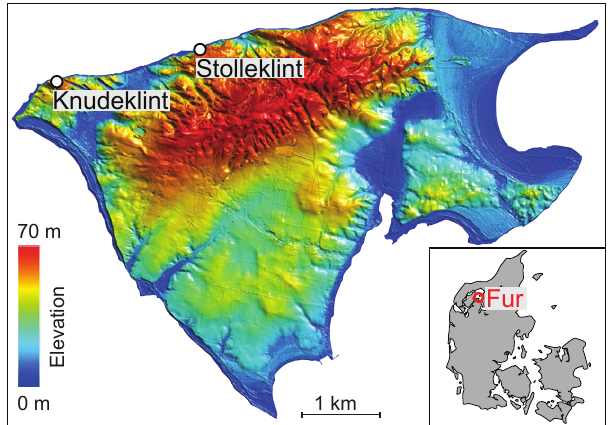
Figure 2: Topographic map of the island of Fur, Den- mark. Ash samples are from two marked locali- ties: Knudeklint (56°50’15"N, 8°57’30"E) and Stollek- lint (56°50’29”N, 8°59’33”E). The high topography in the north of the island marks a partially overturned anticline of Fur Formation and upper Stolleklint Clay strata. Map courtesy of Egon